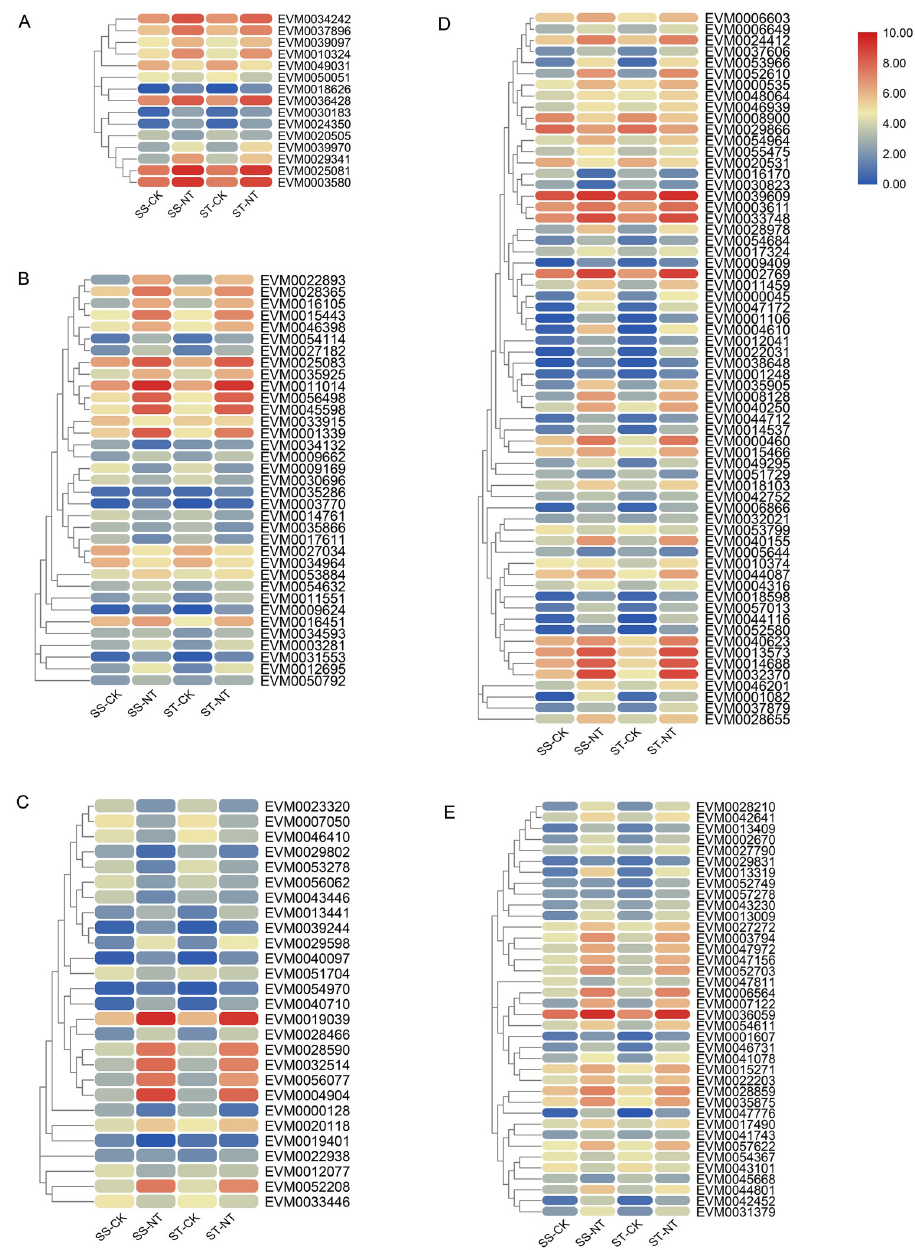
Fig 6. Heatmap of the DEGs coding for five stress-response related TF family members. Five stress-response related TF family members were screened from Salix matsudana genome; the TF DEGs were subjected to hierarchical clustering and heatmap presentation. The average FPKM values of three repeat samples were counted, and the heat map was drawn using Log10-transformed expression values. The color bar indicates the gene expression level. A, Heatmap for DEGs coding for bZIP; B, Heatmap for DEGs coding for NAC; C, Heatmap for DEGs coding for MYB; D, Heatmap for DEGs coding for AP2/ERF; E, Heatmap for DEGs coding for WRKY. DEGs, differentially expressed genes; TF, transcription factor. SS-CK and SS-NT indicate the salt-sensitive group samples treated without and with 150 mM NaCl; ST-CK and ST-NT indicate the salt-tolerant group samples treated without and with 150 mM NaCl. DEGs, differentially expressed